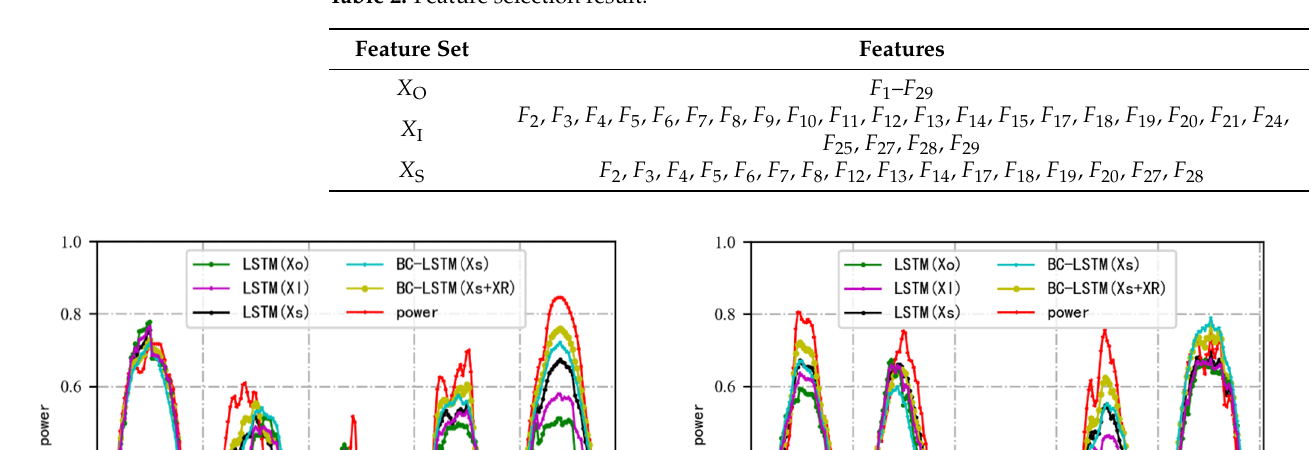
Table 2. Feature selection result.